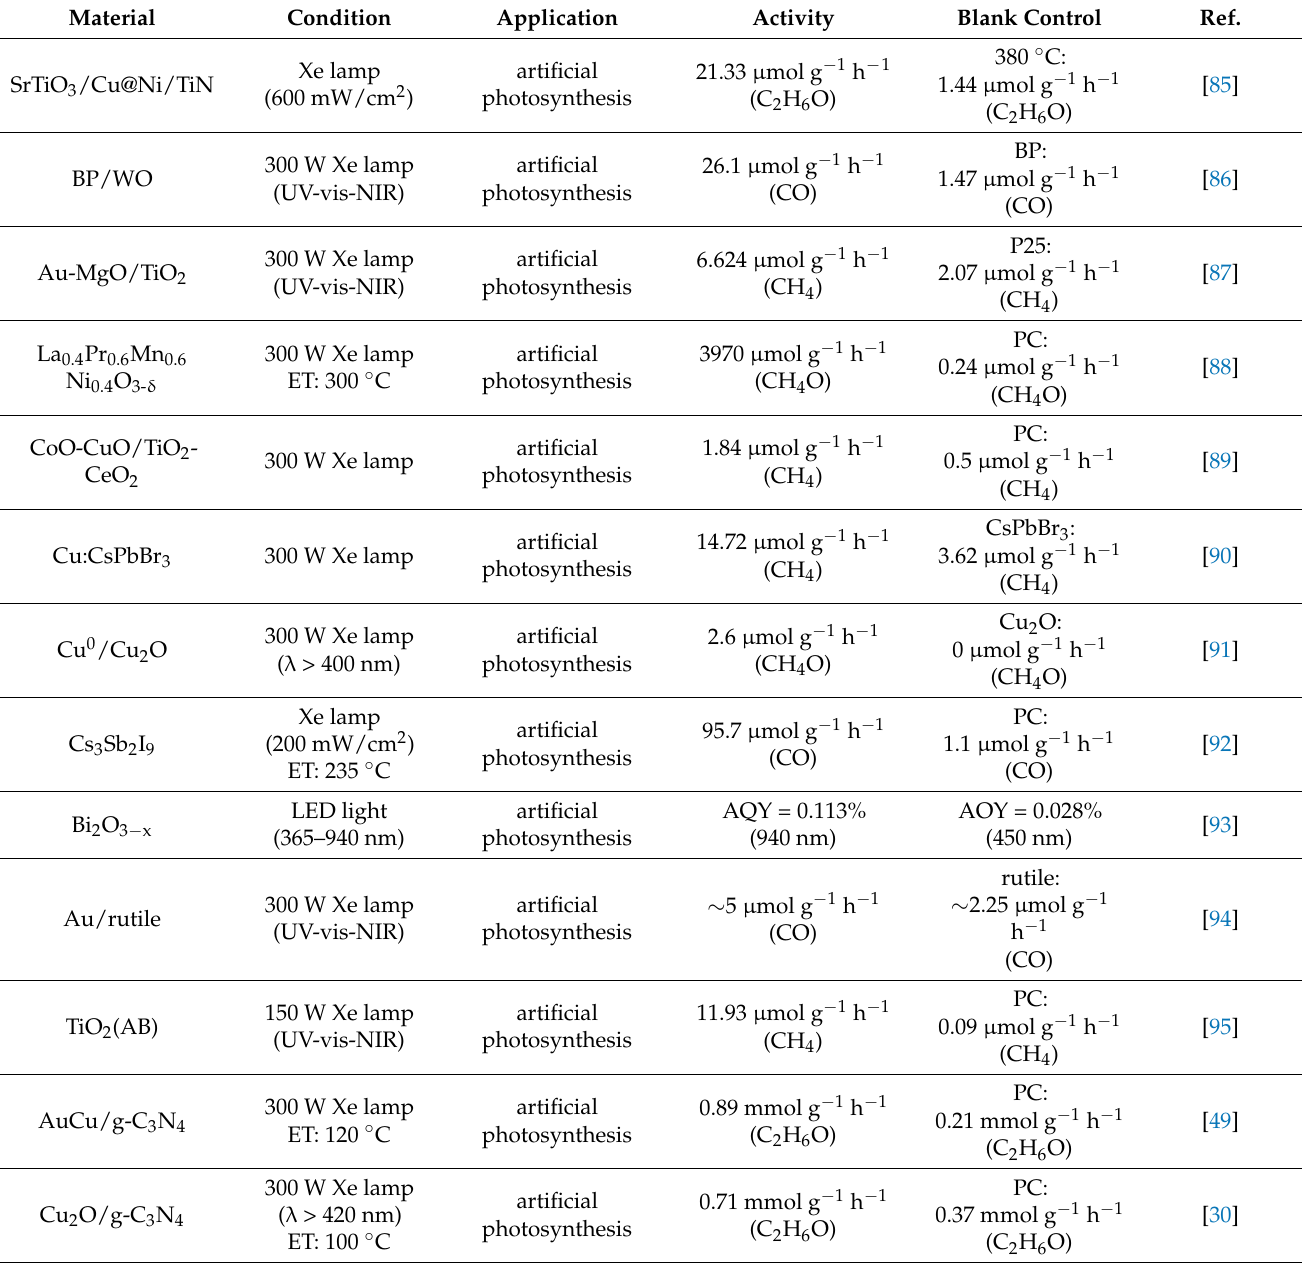
Table 1. Summary of thermal-coupled photocatalysis in recent years.